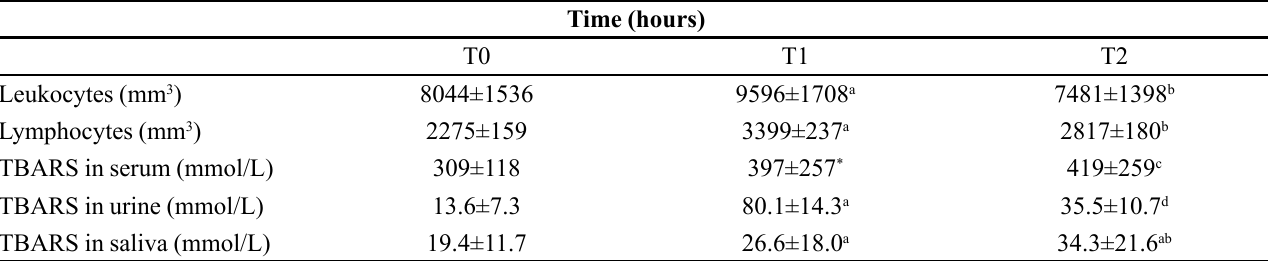
TABLE III – Quantification of leukocytes, lymphocytes and TBARS in the studied times